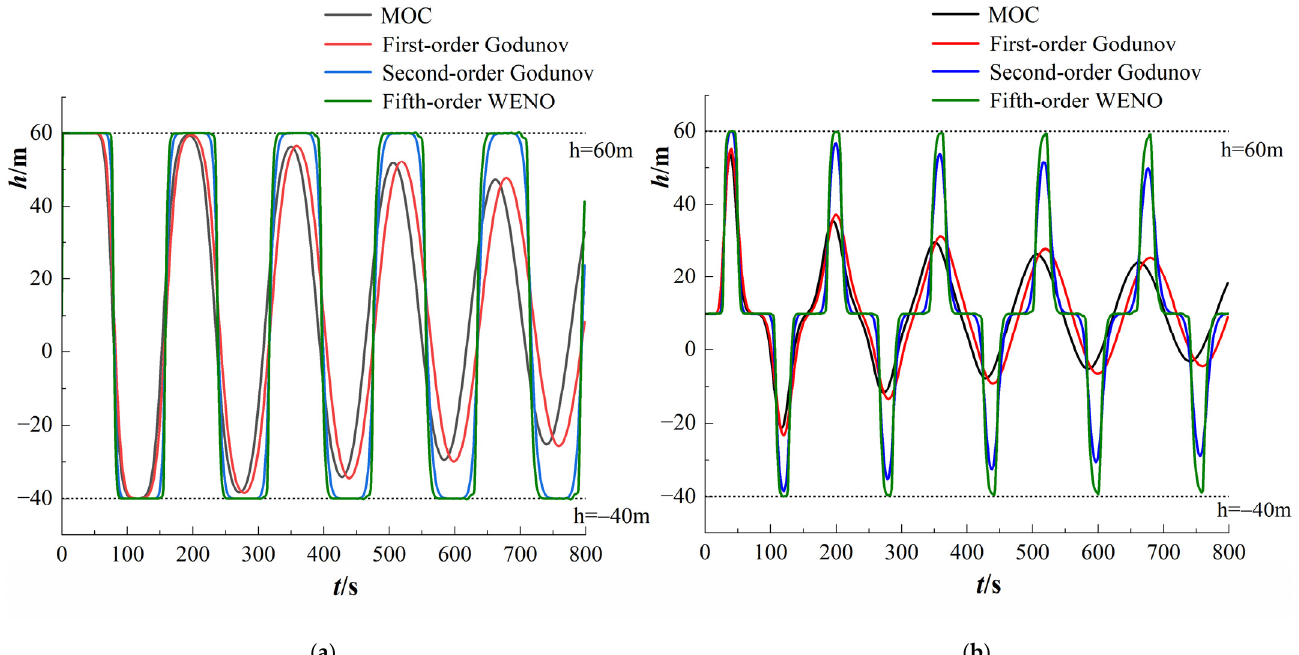
Figure 6. Comparison of results of different schemes for Cr = 0.01. ( a ) Comparison of pressure wave curve at value. ( b ) Comparison of pressure wave curves at 10 km